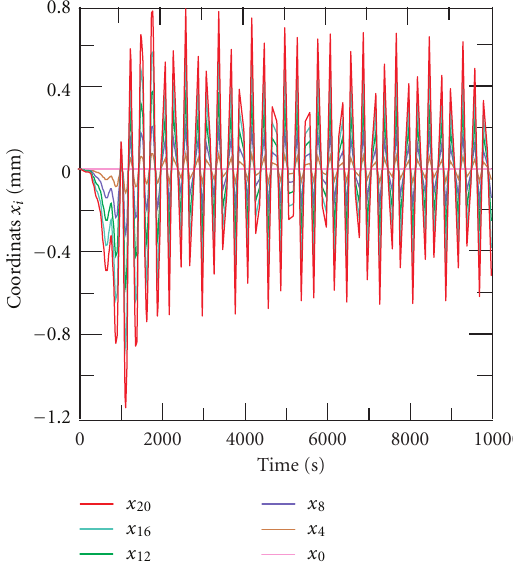
Figure 15: Time histories of general coordinates x i during and after